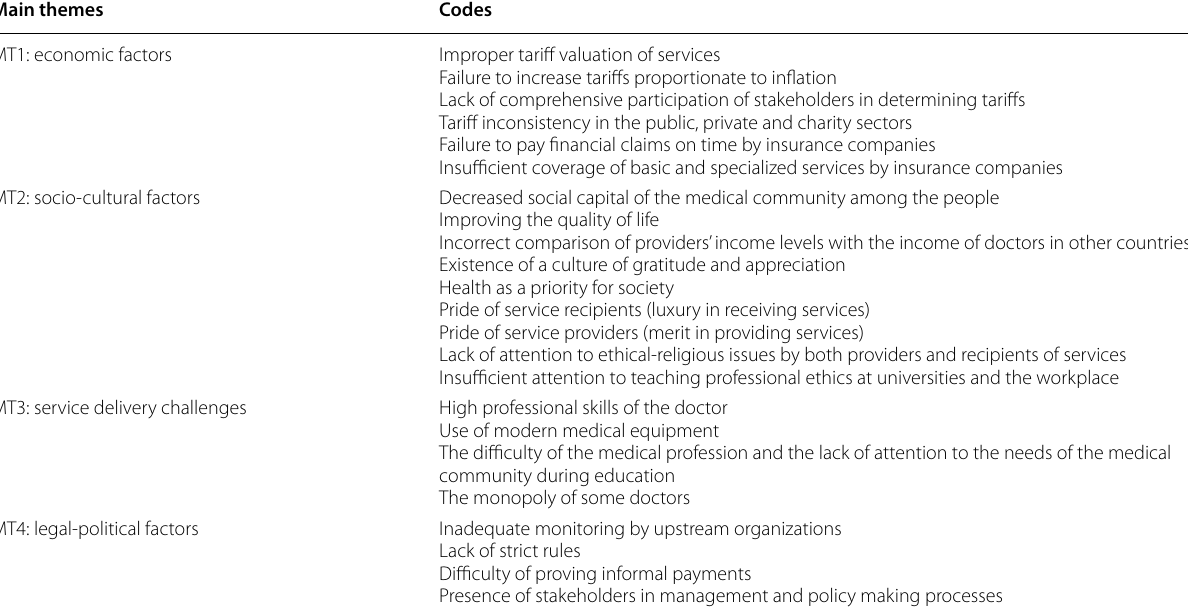
Table 3 Reasons for informal payments from the perspective of health care providers and recipients in